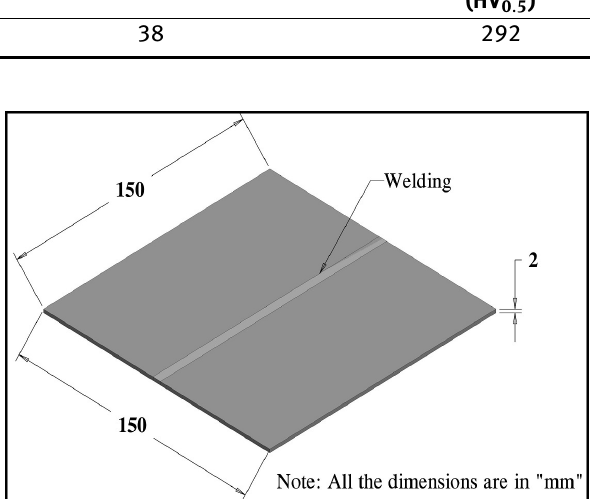
Table 2: Mechanical properties of base metal Tensile strength (MPa)